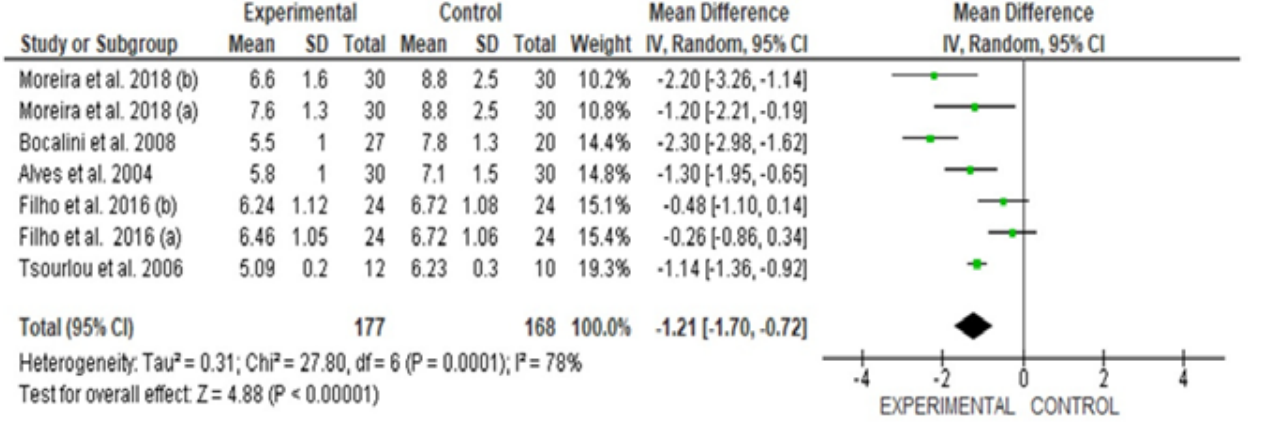
Figure 5. Forest plot of the seven results of the five studies selected for agility measured by the “Sitting, walk 2.44m go back and sit” test (s) in the Rikli Jones test